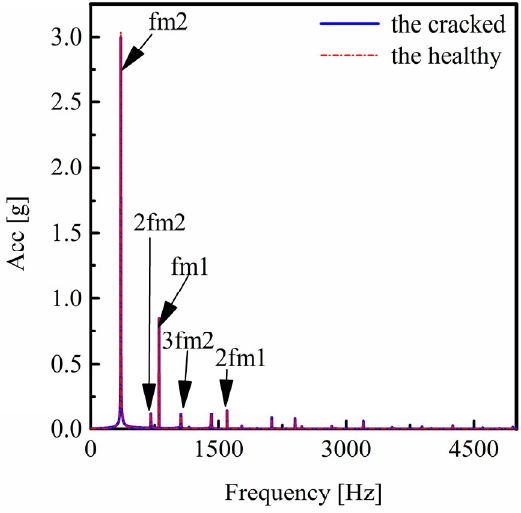
Figure 17. Frequency domain diagram of vibration acceleration of the driven gear in second stage under faulty state.